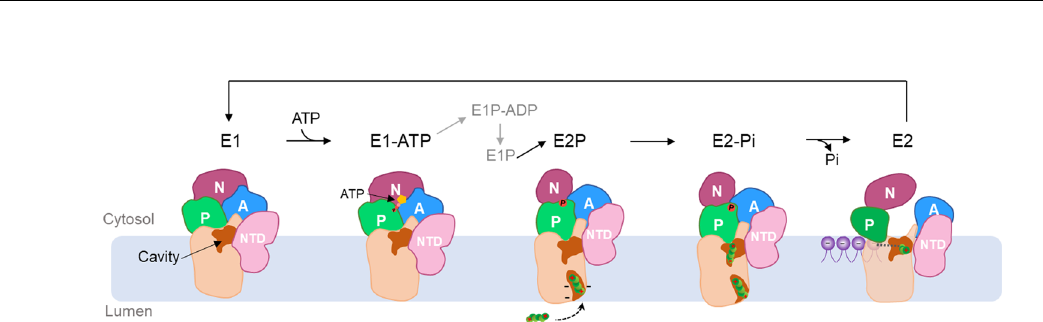
Fig. 5 | Conformational arrangements among intermediate states. a – c ConformationalcomparisonofA,P,andNDomainsintheE1-ATP( a ),E2-Pi( b ), and putative E2 states ( c ). Arrows indicate major domain movements between the compared structures. d – f Cartoon representation of the split movement between